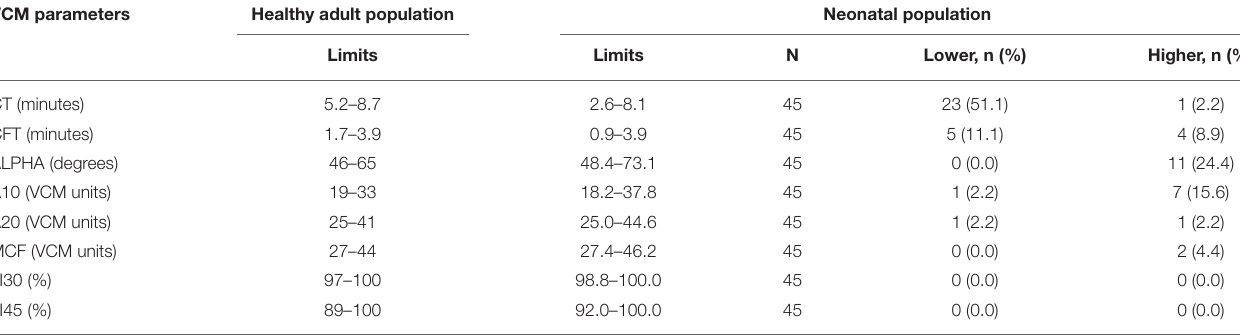
TABLE 4 | VCM profiles, comparison between neonatal population and adult reference